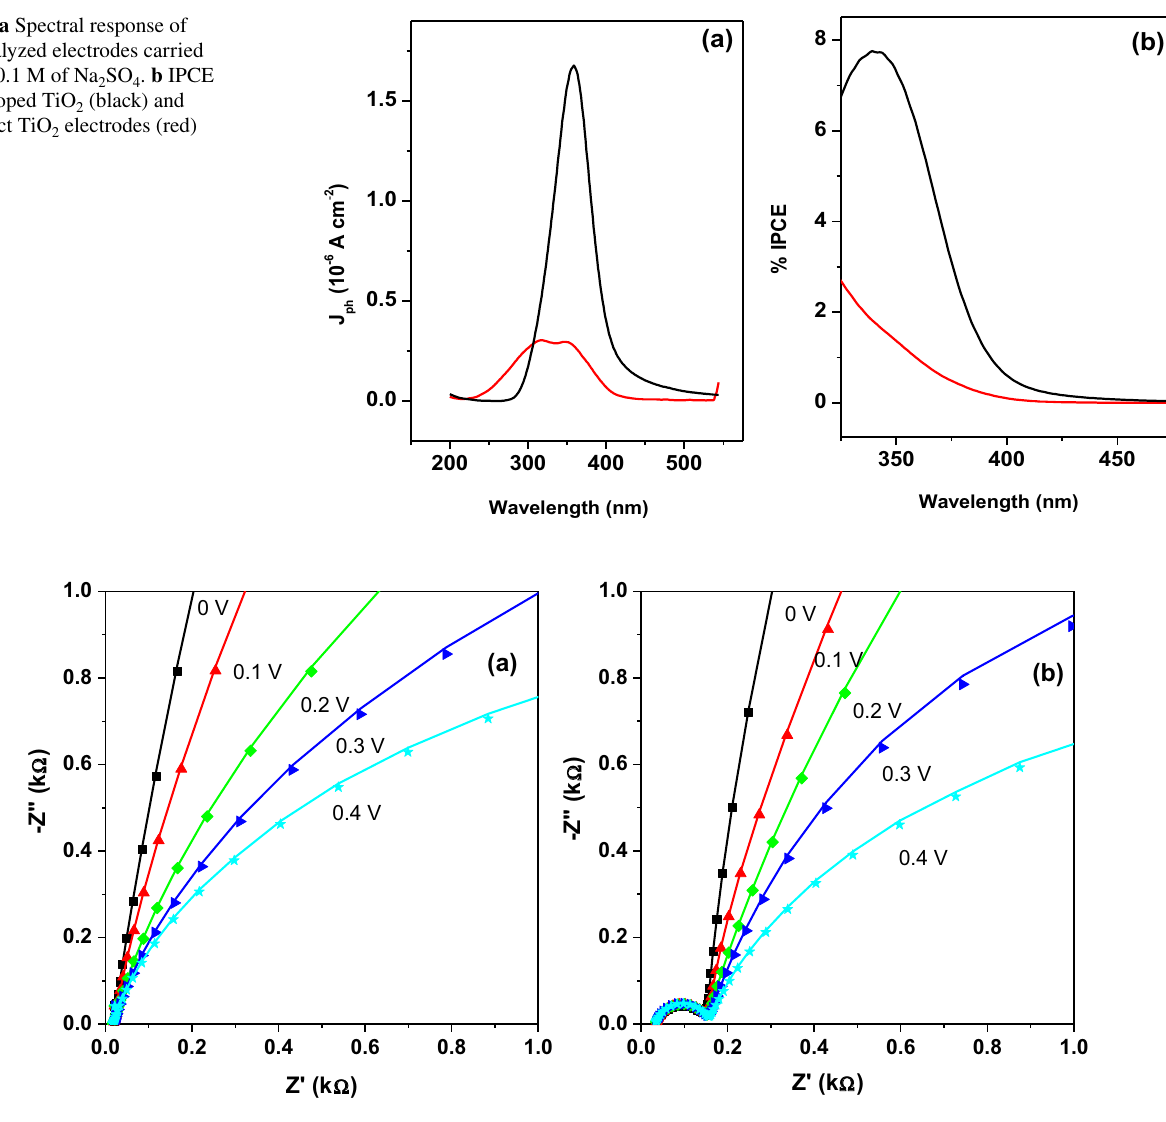
Fig. 5 Nyquist plots of impedance spectroscopy recorded from 0 to 0.4 V. a compact TiO